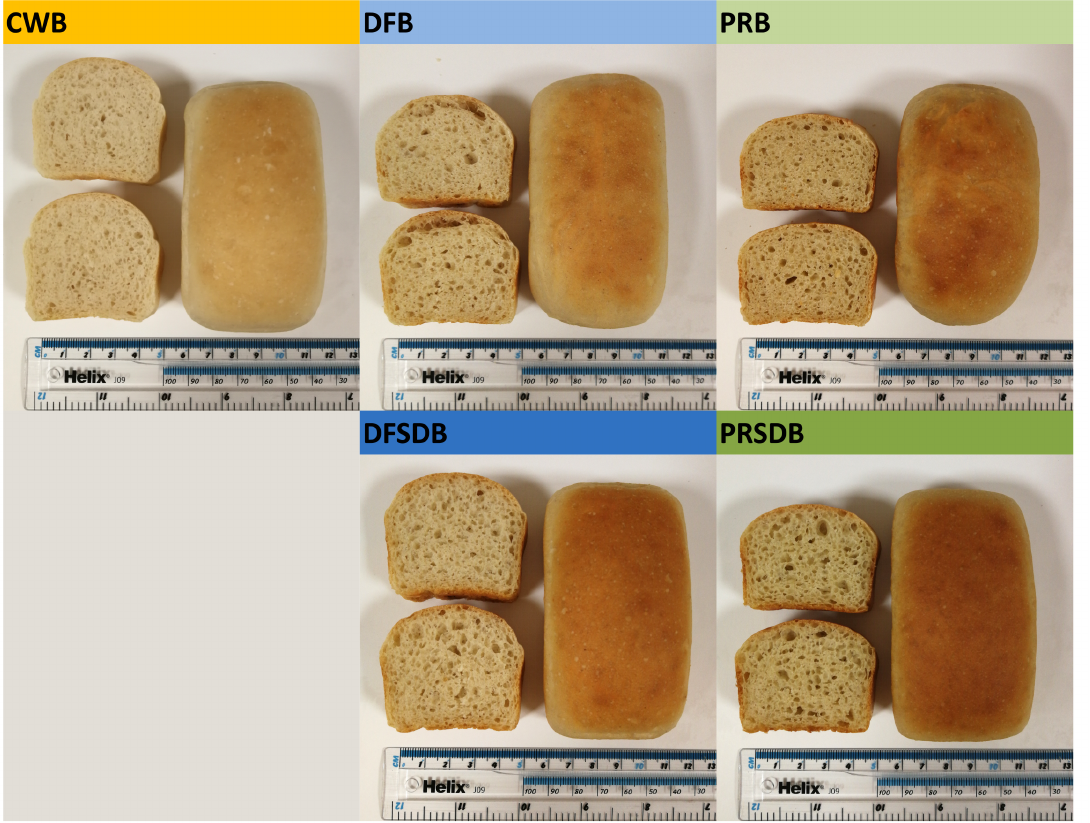
Figure 3. Photographs of control wheat bread and faba bean